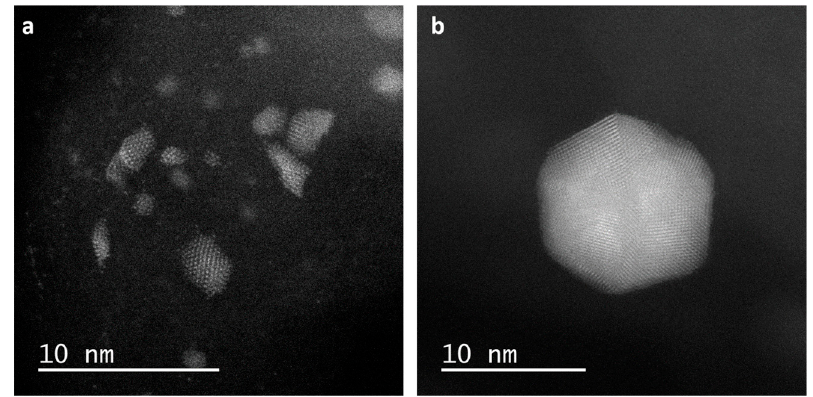
Figure 1. Scanning transmission electron microscope (STEM) high-angle annular dark field images of gold nanoparticles. ( a ) Irregular shape. ( b ) Polyhedral shape (truncated icosahedron).